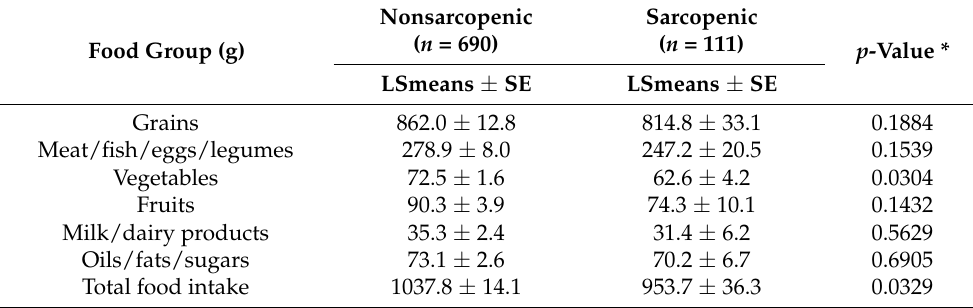
Table 2. Comparison of food group intakes.